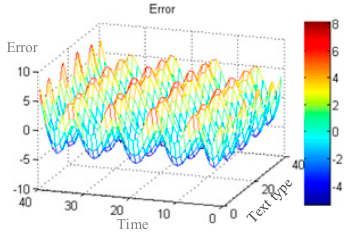
Figure 8. Error of predicted data.